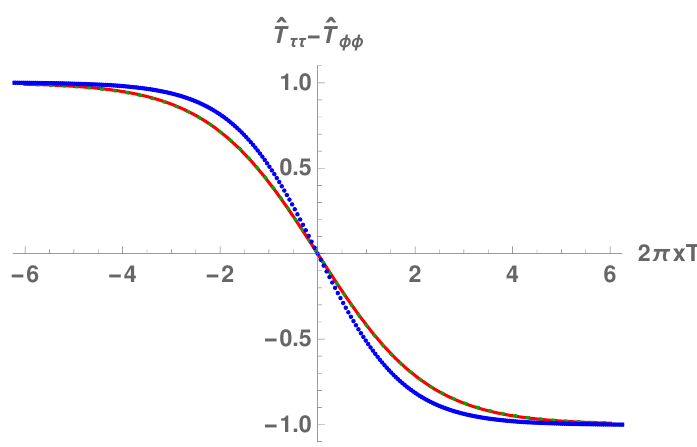
ˆ ˆ Figure 7 . T ττ − T φφ from a simple model compared to the numerical data for the domain wall. The blue dots are numerical data from the exact solution, the red solid curve is given by (3.26) at z = 0 , and the dotted green curve is a tanh fit to the red curve. ˆ (i.e., a nonzero value of x in (3.12)) which are linked to nonzero surface tension. T 0 φφ